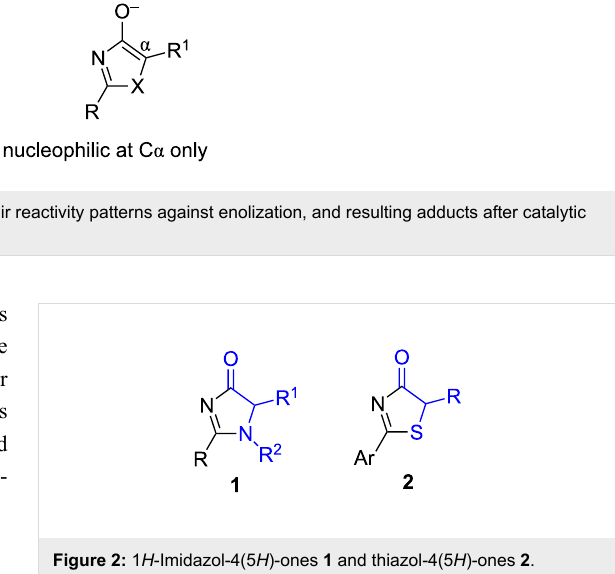
Review 1 1 H -Imidazol-4(5 H )-ones